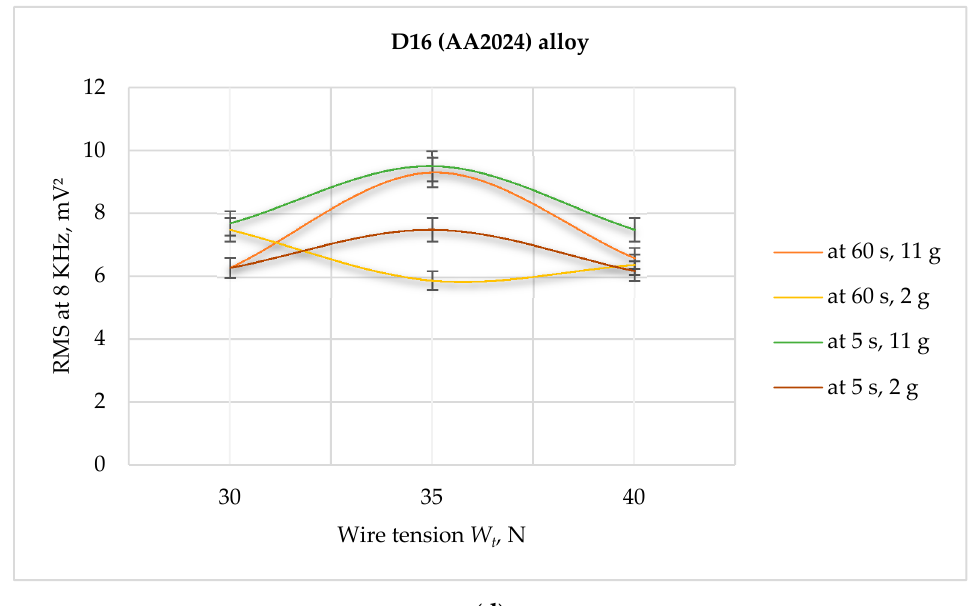
Figure 6. RMS of the received electrical discharge machining oscillation signal at 8 kHz for two types of materials: ( a ) 12Kh18N10T (AISI 321), in dependence on operational voltage V 0 ; ( b ) 12Kh18N10T (AISI 321), in dependence on wire tension W t ; ( c ) D16 (AA2024), in dependence on operational voltage V 0 ; ( d ) D16 (AA2024), in dependence on wire tension W t .